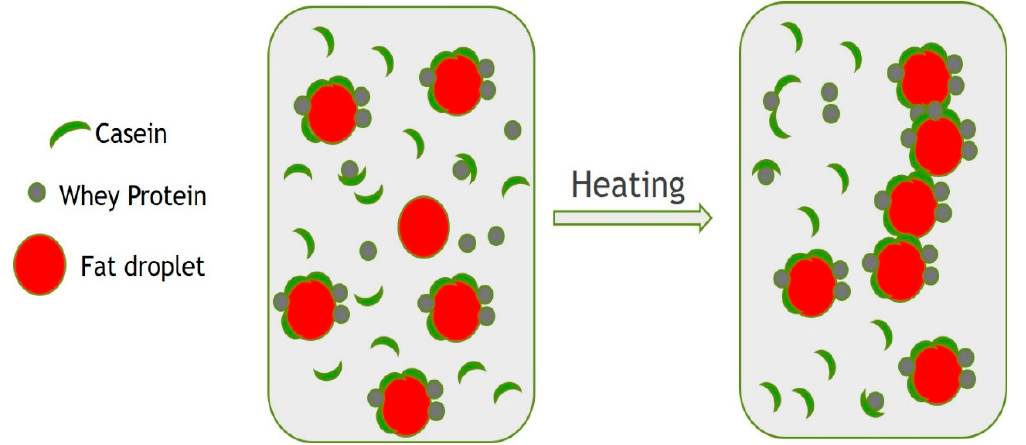
Figure 9. Interactions between different milk components during heat treatment.